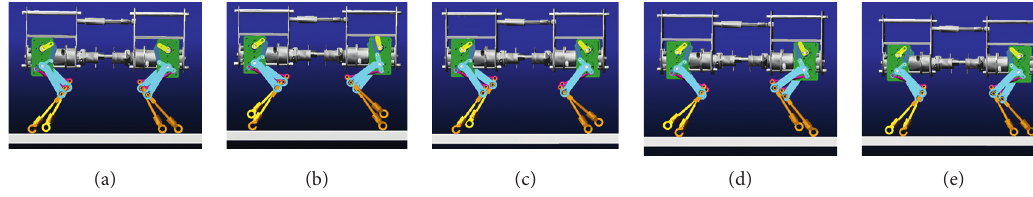
Figure 17: The motion of a period of flight phase. (a) t � 0s. (b) t � 0.25s. (c) t � 0.5s. (d) t � 0.75s. (e) t � 1s.